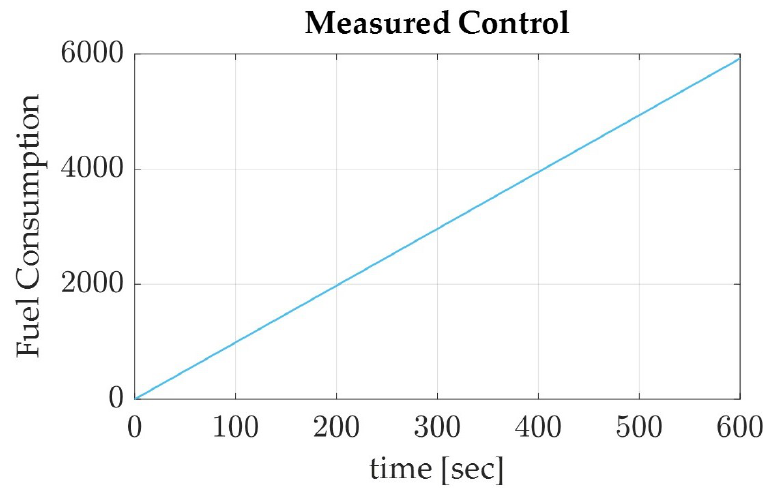
Figure 8. The control measured in terms of thrust applied, which can be estimated for fuel consump- tion, for a de-orbiting spacecraft using the Pontryagin’s autonomous trajectory in LEO.